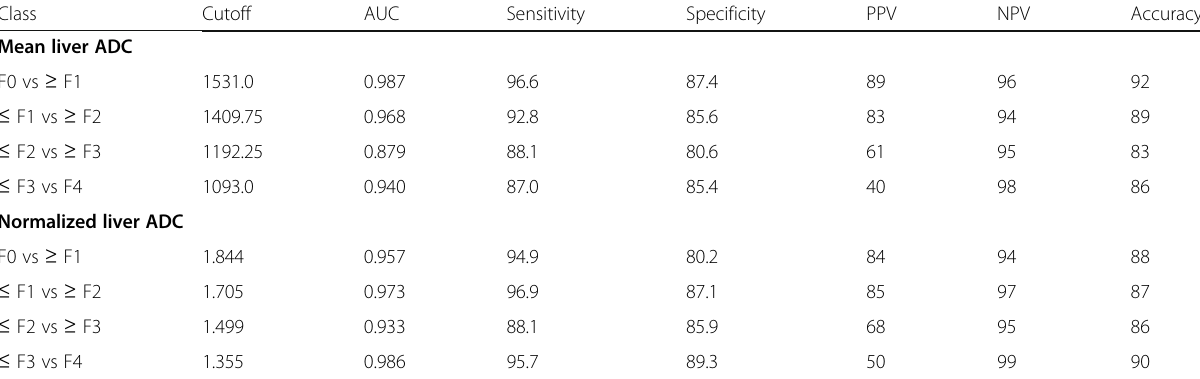
Table 5 Comparison between mean liver ADC and normalized liver ADC regarding the diagnostic performance and cutoff values Class Cutoff AUC